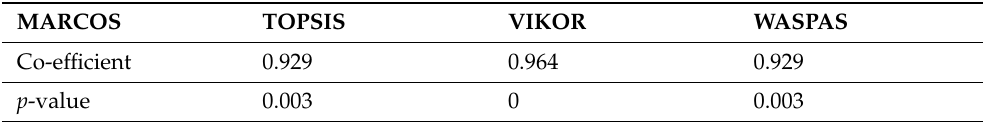
Table 15. Spearman test.